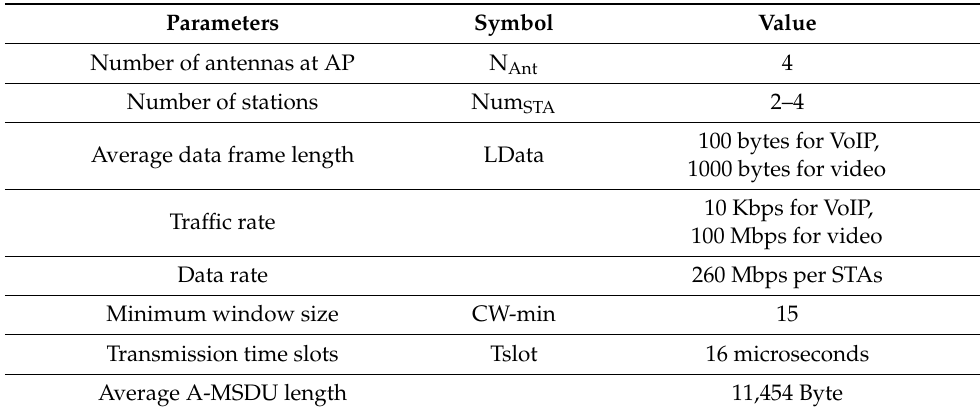
Table 1. Simulation